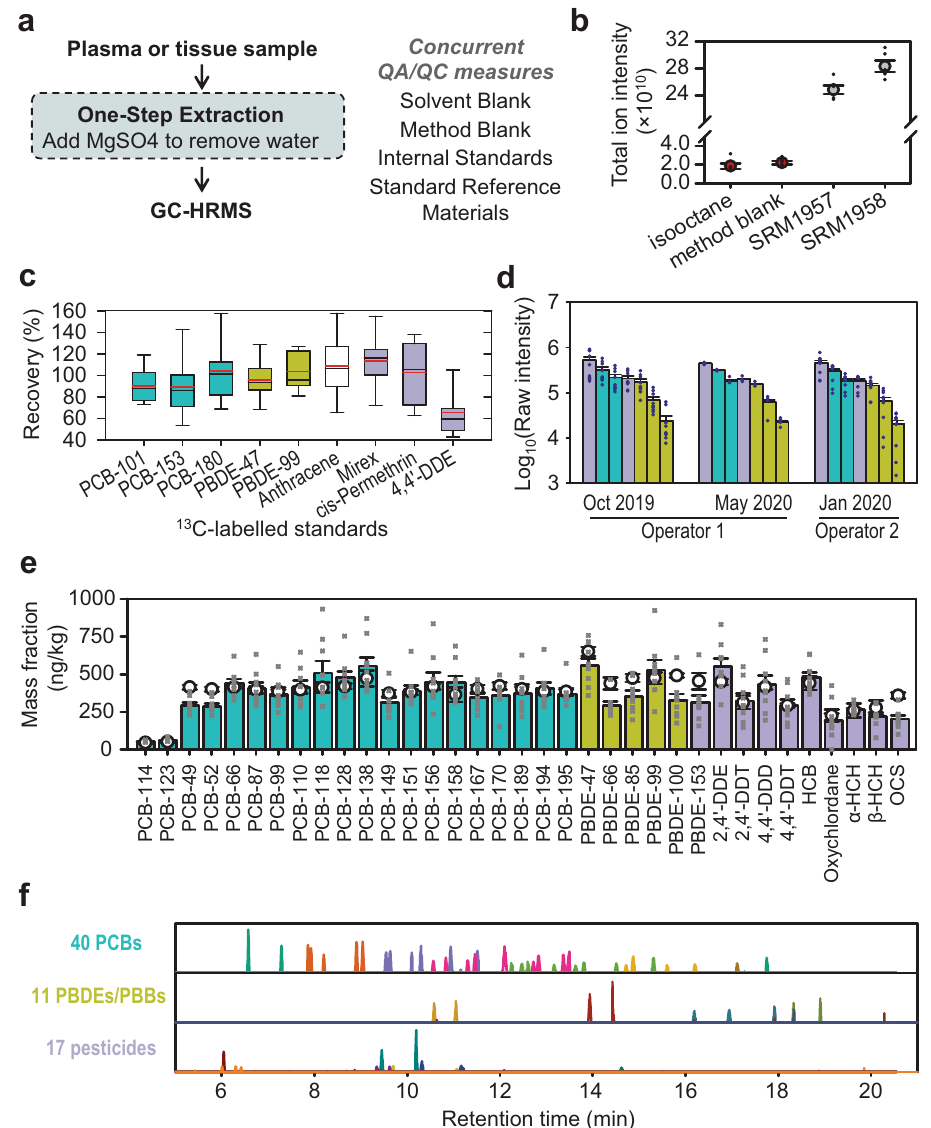
Fig. 2 XLE provides single-step extraction to minimize variation in chemical recovery for untargeted environmental biomonitoring. a XLE minimizes the number of sample-processing steps for use with GC – HRMS for measurement. b Inclusion of method blanks showing similar signal level as directly injected isooctane solvent supports quality control (QC) and standard reference material (NIST SRM-1957, 1958) in each sample batch supports quality assurance (QA). Total ion intensity was calculated by the sum of intensity of all detected peaks ( n = 6 independent experiments). Data are presented